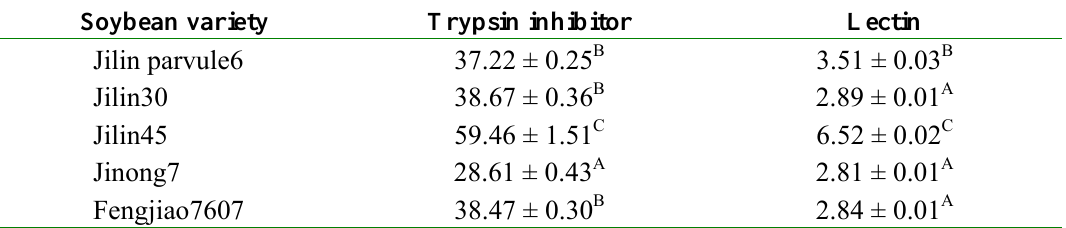
Table 2. Soybean trypsin inhibitor and lectin content(mg/g). Soybean